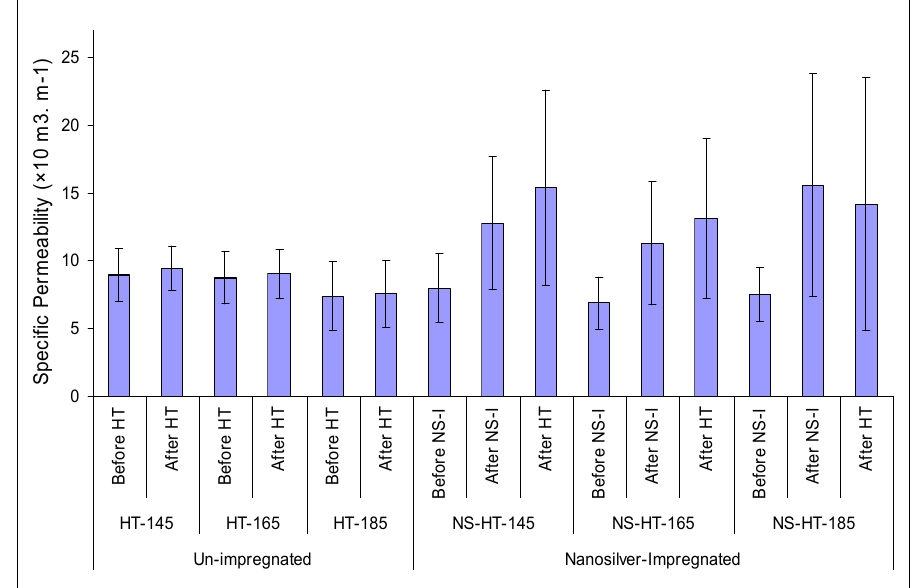
Figure 2. Specific longitudinal gas permeability in the beech specimens ( × 10 − 13 m 3 m − 1 ) (error bars indicate the standard deviation for each column).